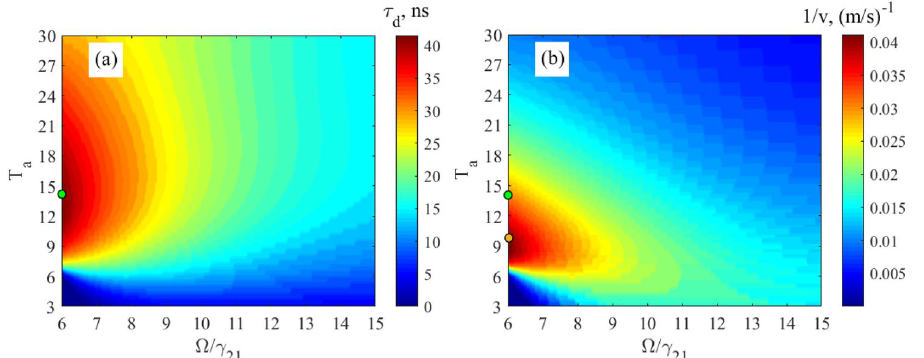
3 γ 21 ( γ 4.7 γ 21 and B 1.88 γ 21 ), incident wave packet S = = = 6 and p 2.4 . γ 21 p 1 = = = (cid:31)